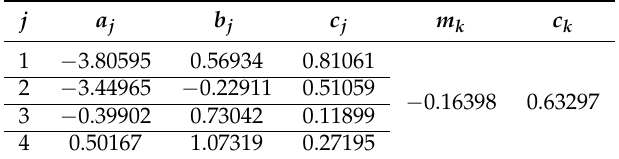
Table A4. Coefficients for k V .